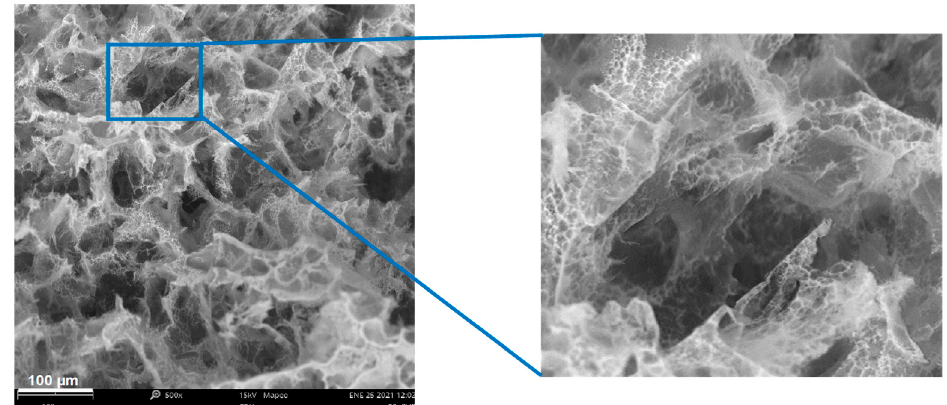
Figure 5. Ternary blend scaffold P3 at the scale bars is shown in the micrograph, interconnected walls, and micropores inside the largest pores.